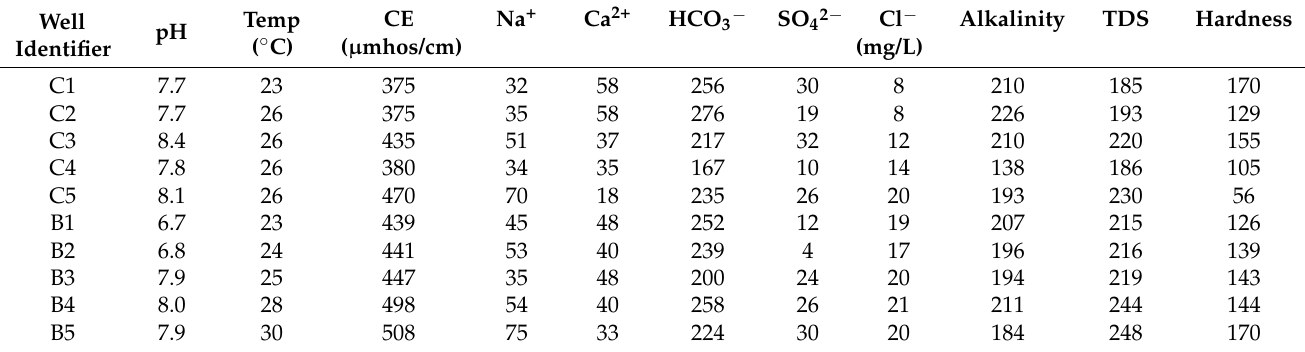
Table 2. Ion concentrations of the water samples.